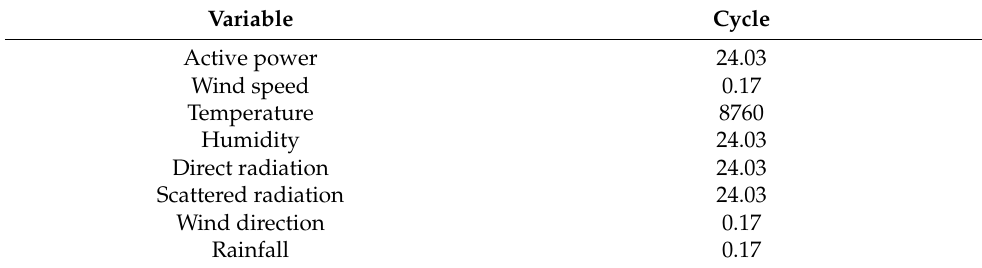
Table 3. Results of periodicity